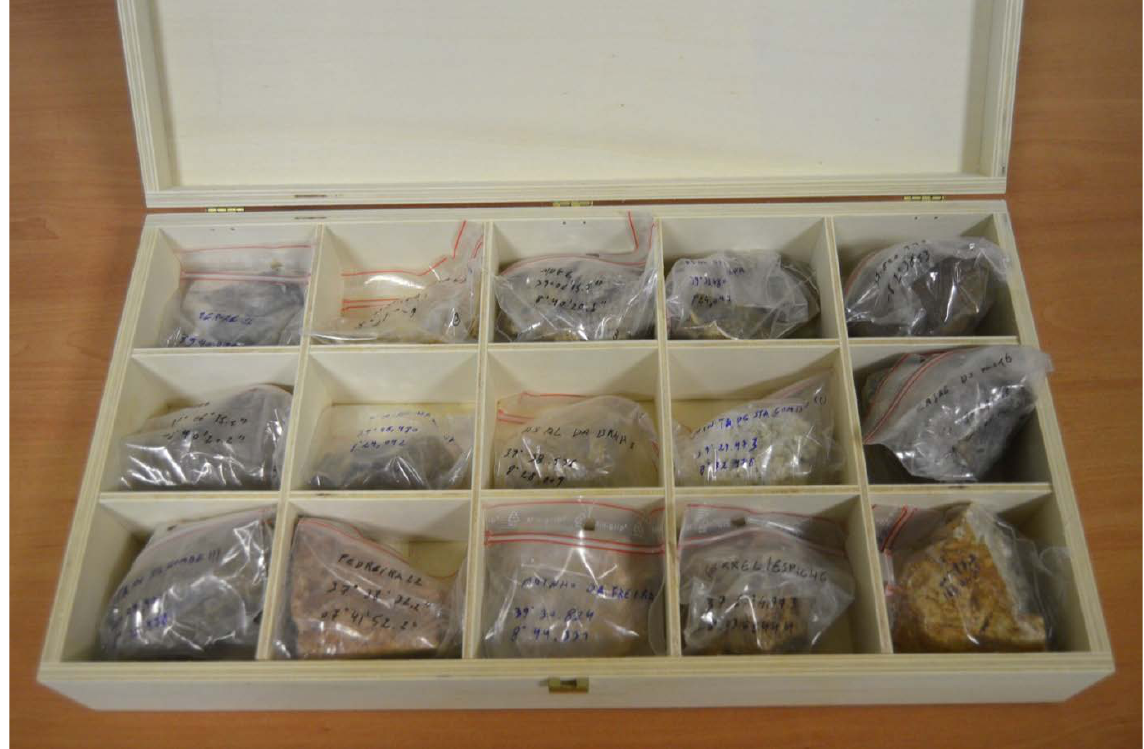
Figure 2. Custom-made poplar wood boxes with some of the hand geological samples from